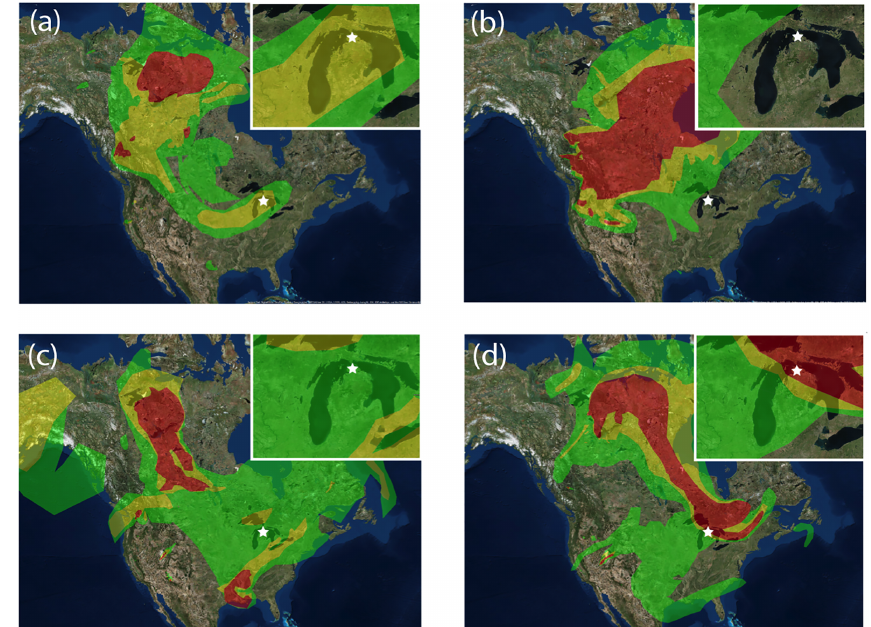
Figure 4. Representative NOAA HMS smoke maps for four representative days during the time periods of different air influence: (a) 14 July, wildfire influence; (b) 16 July, remote background influence; (c) 21 July, urban influence; (d) 24 July, wildfire influence. Inset enlarges the state of Michigan to clearly display smoke influence on the field site, shown as a star.